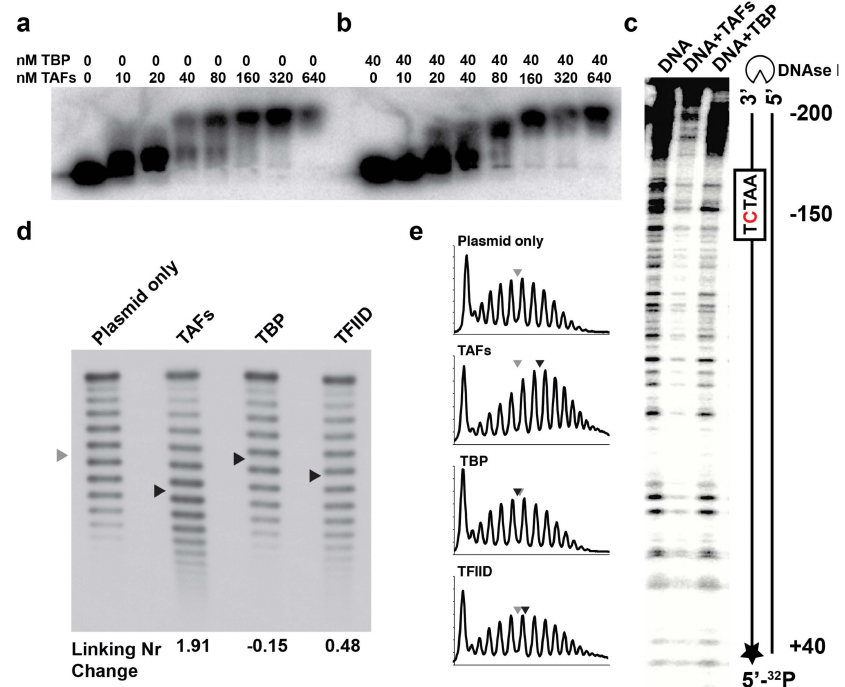
Figure 2. DNA binding experiments. ( a ) Electrophoretic mobility gel-shift assay (EMSA) in 0.8% Mg–agarose gel showed that the TAF complex binds the RPS5 promoter with nM a ffi nity. ( b ) EMSA with addition of a constant amount of TBP while titrating TAFs. ( c ) DNAse I footprinting assay with 240 bp of RPS5 promoter. The TAF complex introduced an extended footprint, spanning ~200 bp DNA. TBP introduced a small footprint in the region around the pseudo-TATA-box. ( d ) Topoisomerase I assay showed a fourfold increase in positive supercoiling for TAFs vs TFIID. The centers of the distributions are indicated with arrows. ( e ) Intensity distribution profiles of the bands in ( d